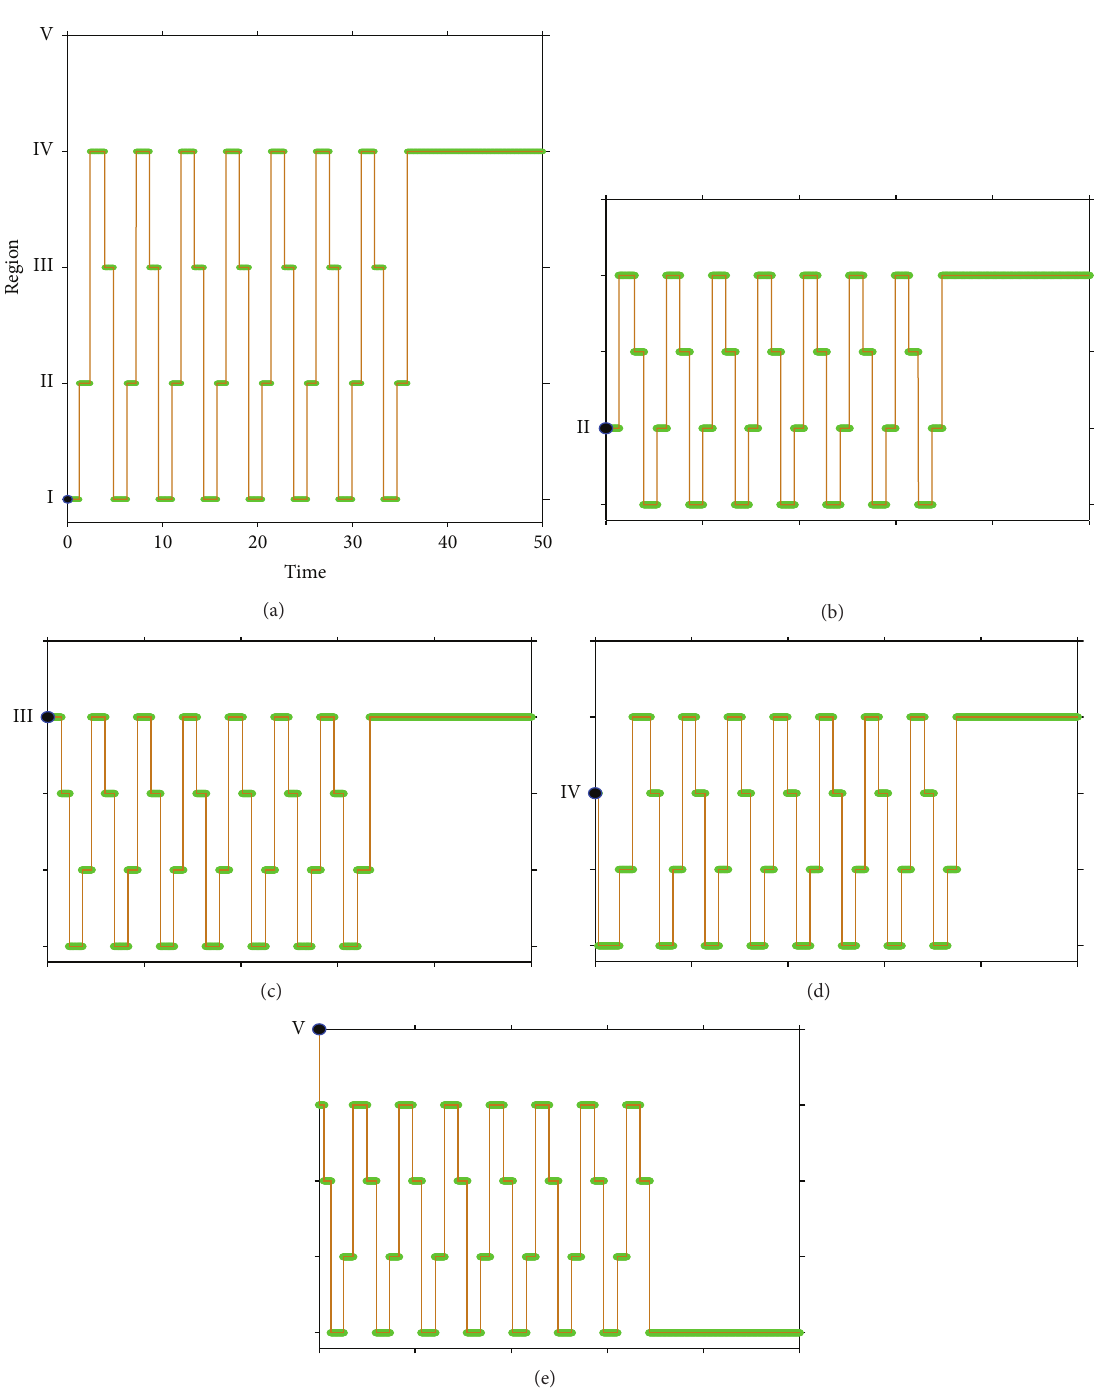
Figure 3: The region containing (𝑥 1 𝑘 ,𝑥 2 𝑘 ,𝑥 3 𝑘 ) at time 𝑡 = 𝑘Δ𝑡 for the five trajectories in Figure 2. (a) The initial point (𝑥 1 0 , 𝑥 2 0 , 𝑥 3 0 ) is (0.5, 0.375, 0.3562), denoted by the black circle and located at (0, I ) . The green segments denote the regions containing (𝑥 1 𝑘 , 𝑥 2 𝑘 , 𝑥 3 𝑘 ) . The region having 𝑃 is connected to the region having 𝑇(𝑃) by the brown line. The other figures (b), (c), (d), and (e) are similarly obtained by using the different initial points in Figure